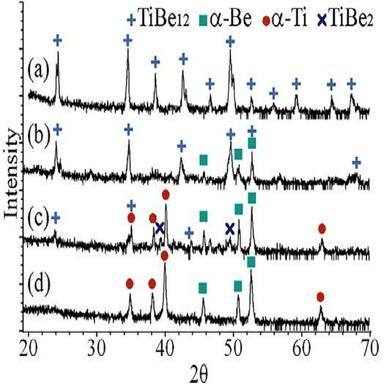
X-ray diffraction patterns showing (a) a formation of single phase TiBe12 at 1100-1275°C, and a mixture of beryllides and pure Be and Ti phases at (b) 1000°C, (c) 800°C, (d) 650°C.